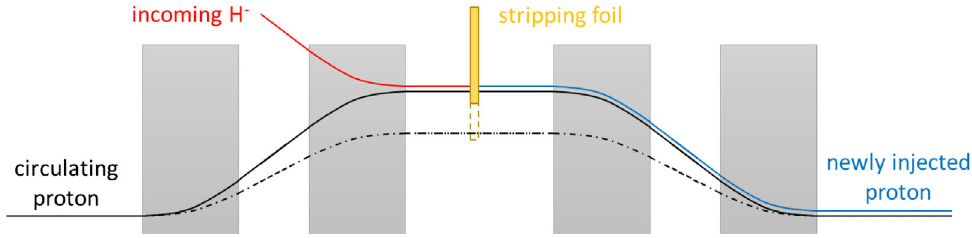
FIG. 3. Schematic of the injection region in the SNS ring. Combinations of dipoles and dynamic kickers are depicted in grey. Dotted lines denote the beam ’ s path and position of the stripping foil when the magnets have a different